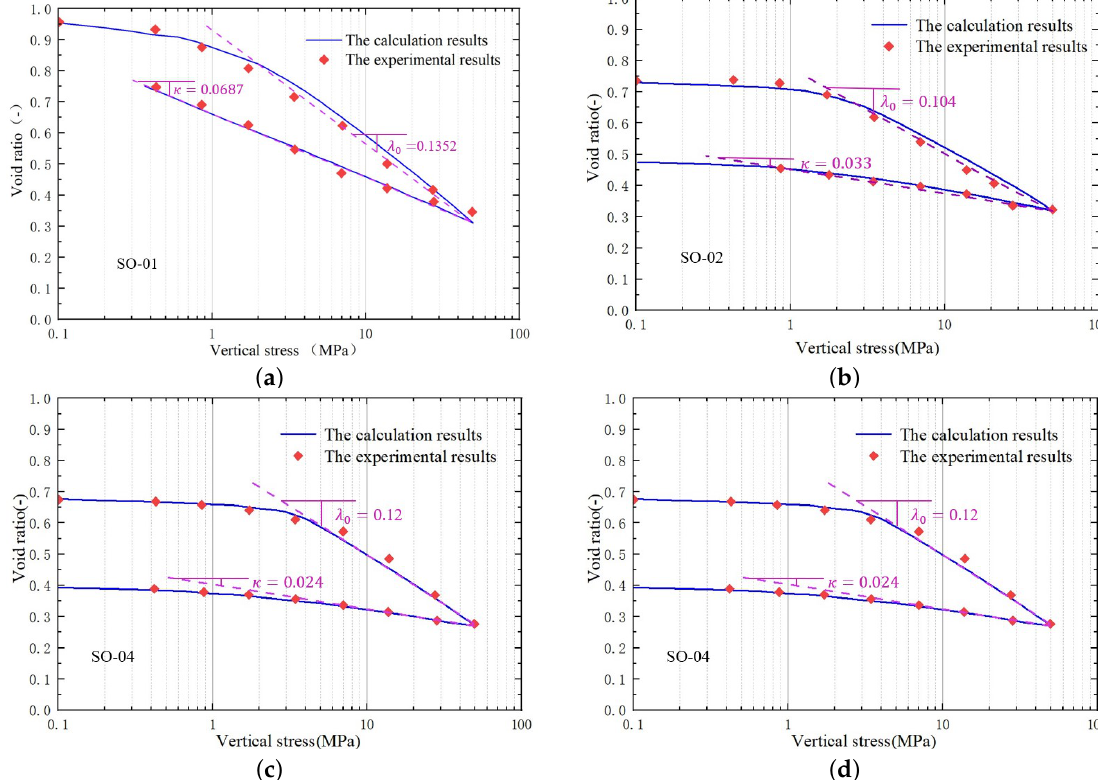
Figure 6. Experimental and numerical void ratio vs. vertical stress of suction controlled compression. ( a – d ) corresponding to samples SO-01 to